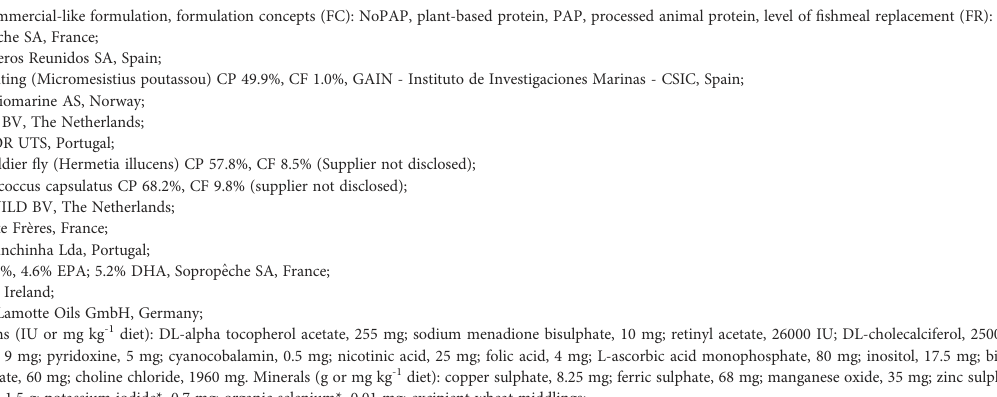
Experimental diets